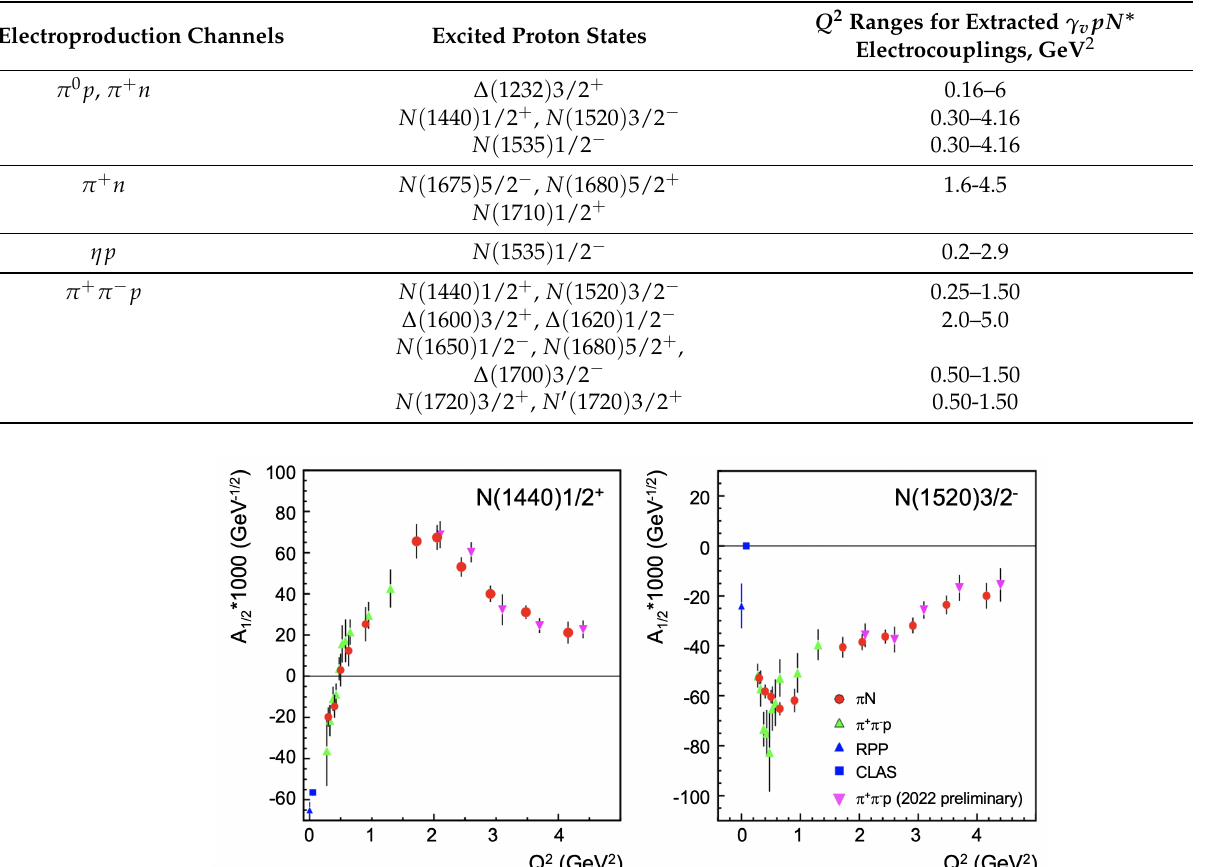
Table 2. Summary of the results for the γ v pN ∗ electrocouplings from the π N , η p , and π + π − p electroproduction channels measured with the CLAS detector in Hall B at JLab.